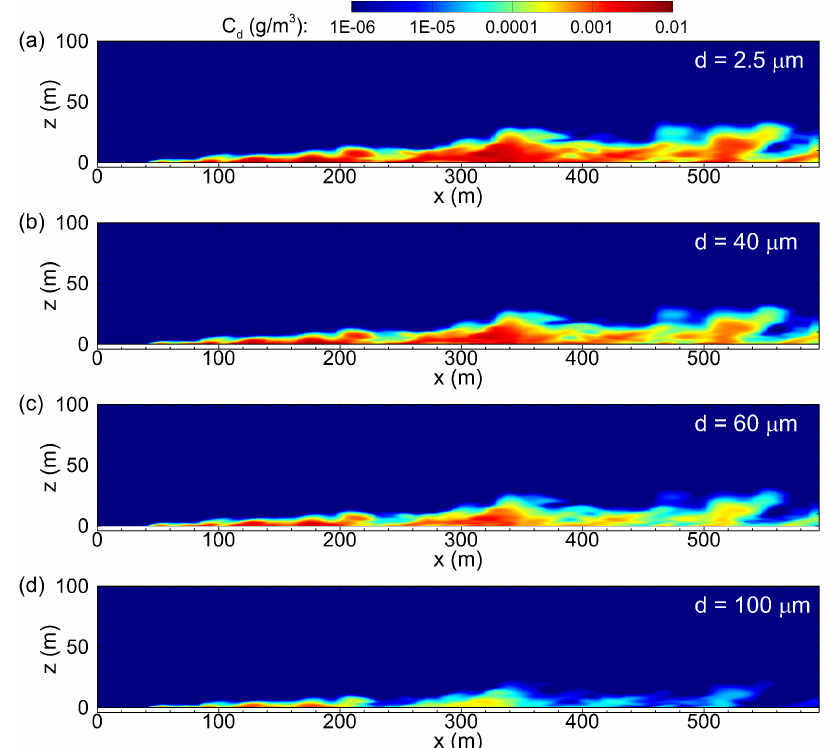
Figure 5. Instantaneous oil aerosol concentrations on the ( x , z ) -plane across the center of the surface release region for the flat-surface case: ( a ) d = 2.5 µ m; ( b ) d = 40 µ m; ( c ) d = 60 µ m; ( d ) d = 100 µ